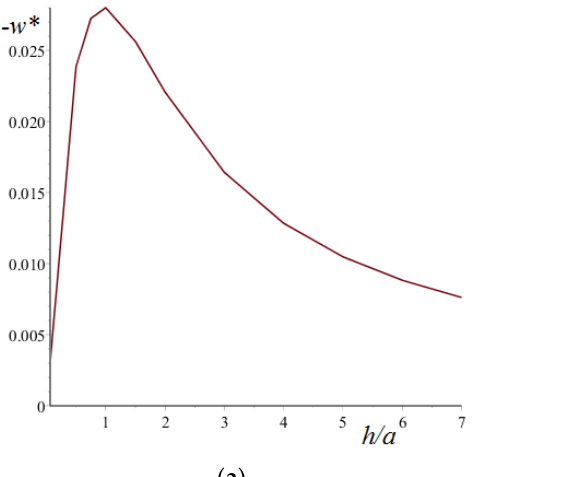
= 10 − 3 , ν = 0.48, ν = 0.3, 2 1 / E 2 1